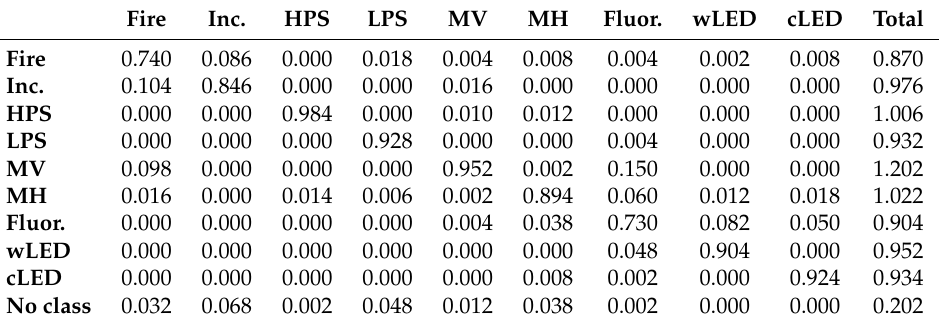
Table 2. Radiation source confusion matrix (relative). Columns and rows represent true classes and predicted